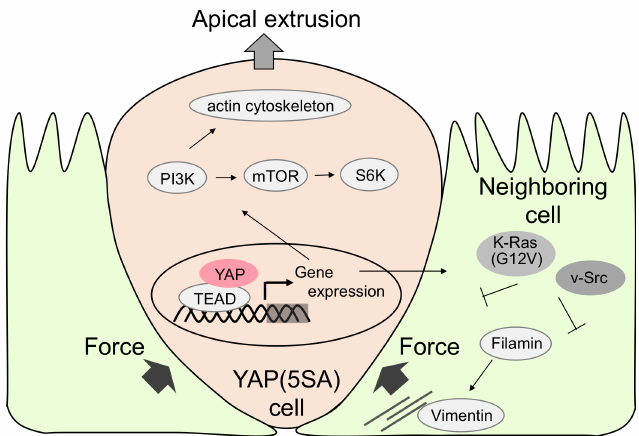
Figure 2. Molecular mechanism of apical extrusion of active YAP-expressing Madin–Darby canine kidney (MDCK) cells. Active YAP induces TEA domain transcription factor (TEAD)-dependent gene expression, which activates Phosphoinositide 3-kinase (PI3K) and Mammalian target of rapamycin (mTOR) signals. This is recognized by neighboring cells in which filamin accumulation induces pressure for apical extrusion of YAP active cells. In contrast, active Ras or Src in the neighboring cell inhibits apical